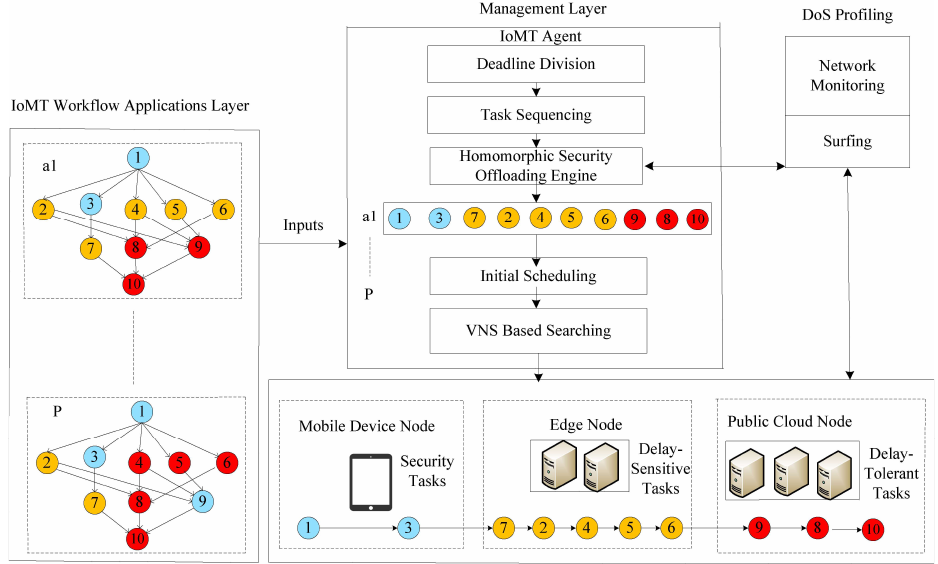
Figure 1. LSEOS metaheuristic and